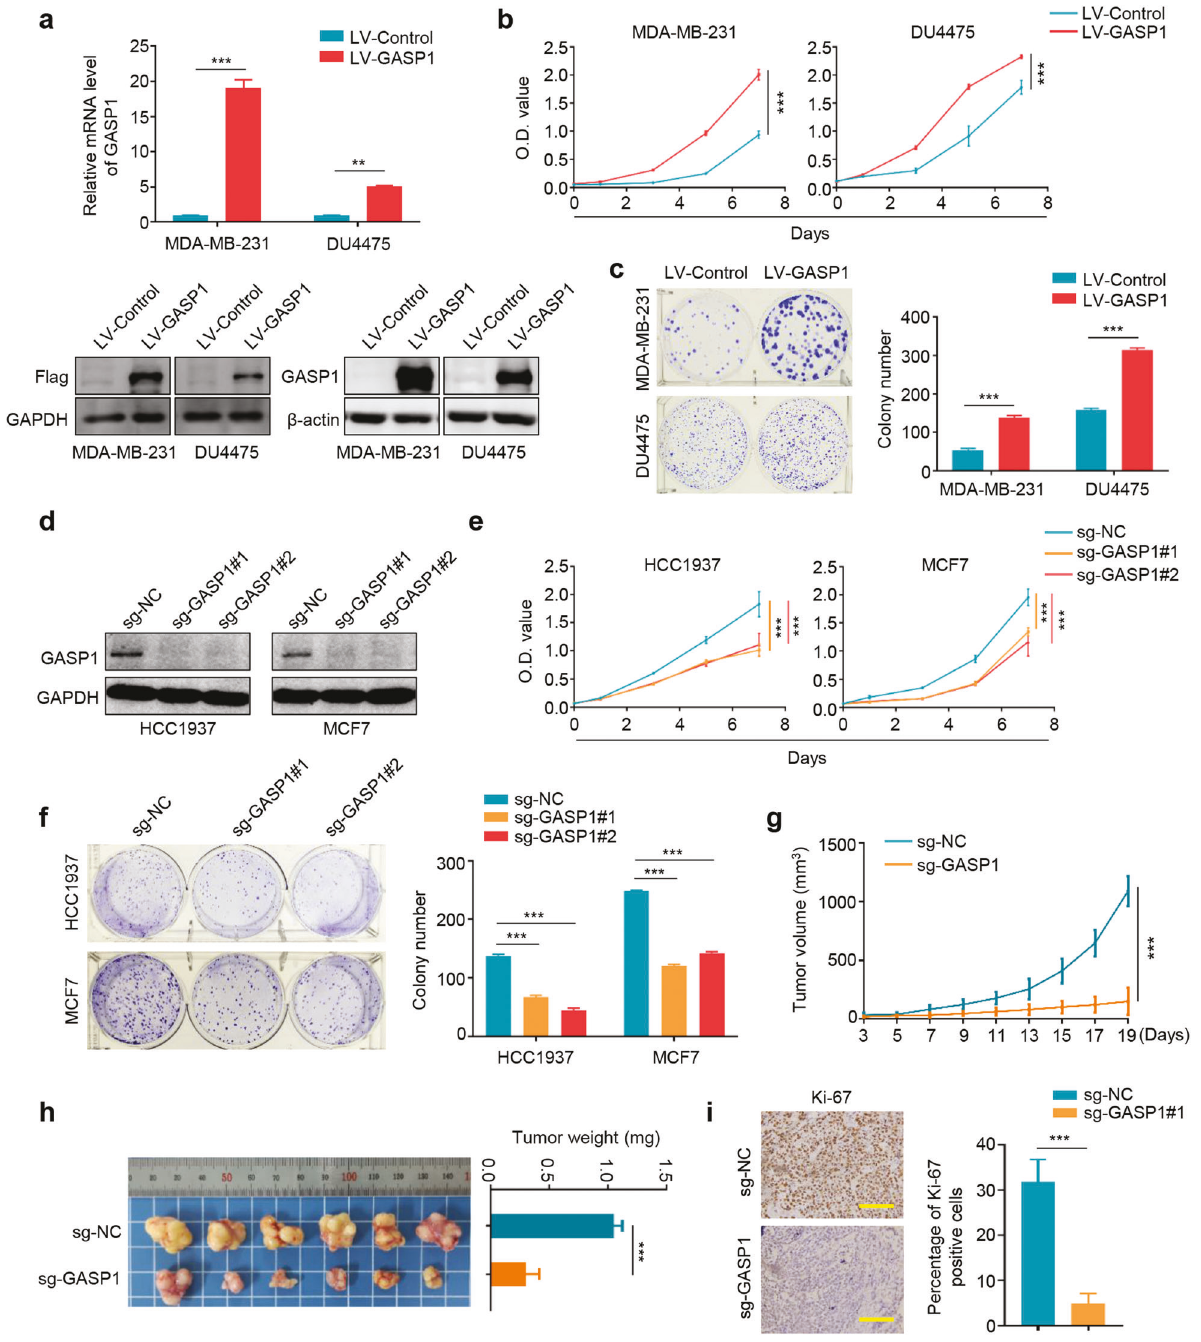
Fig. 2 The promoting effect of GASP1 on the growth of breast cancer cells. a Stable expression of GASP1 in MDA-MB-231 and DU4475 cells was con fi rmed by qRT-PCR and western blot assays. β -actin was used to normalize GASP1 expression. GAPDH and β -actin were used as the loading controls. b MTT showing the effect of GASP1 overexpression on the proliferation of MDA-MB-231 and DU4475 cells. c The effect of GASP1 overexpression on colony formation ability of MDA-MB-231 and DU4475 cells. Quantitative analysis of colony numbers is shown in the right panel. d GASP1 knockout by CRISPR-Cas9 technology was validated by western blot analysis. e , f GASP1 knockout in HCC1937 and MCF7 cells signi fi cantly inhibited cell growth and colony formation. g Xenograft tumor growth curves of GASP1 knockout MCF7 cells and control cells in nude mice ( n = 6/group). h Images of the indicated xenograft tumors and statistical analysis of tumor weight. i The levels of Ki-67 proteins in the xenograft tumors by IHC assay (left panels). Statistical analysis of the percentage of Ki-67-positive cells was shown in the right panels. Scale bars, 200 µm. Data were presented as mean ± SD. ** P < 0.01; *** P < decreased tumor weight (Fig. 2h) compared with the control. As We next established the xenograft tumor model by subcuta- supported, there was a lower percentage of Ki-67-positive cells in neously injecting GASP1 knockout MCF7 cells and control cells GASP1 knockout tumors than in control tumors (Fig. 2i). These into mammary fat pads of nude mice, and found that GASP1 results indicate oncogenic functions of GASP1 in breast cancer. knockout signi fi cantly slowed down tumor growth (Fig. 2g) and